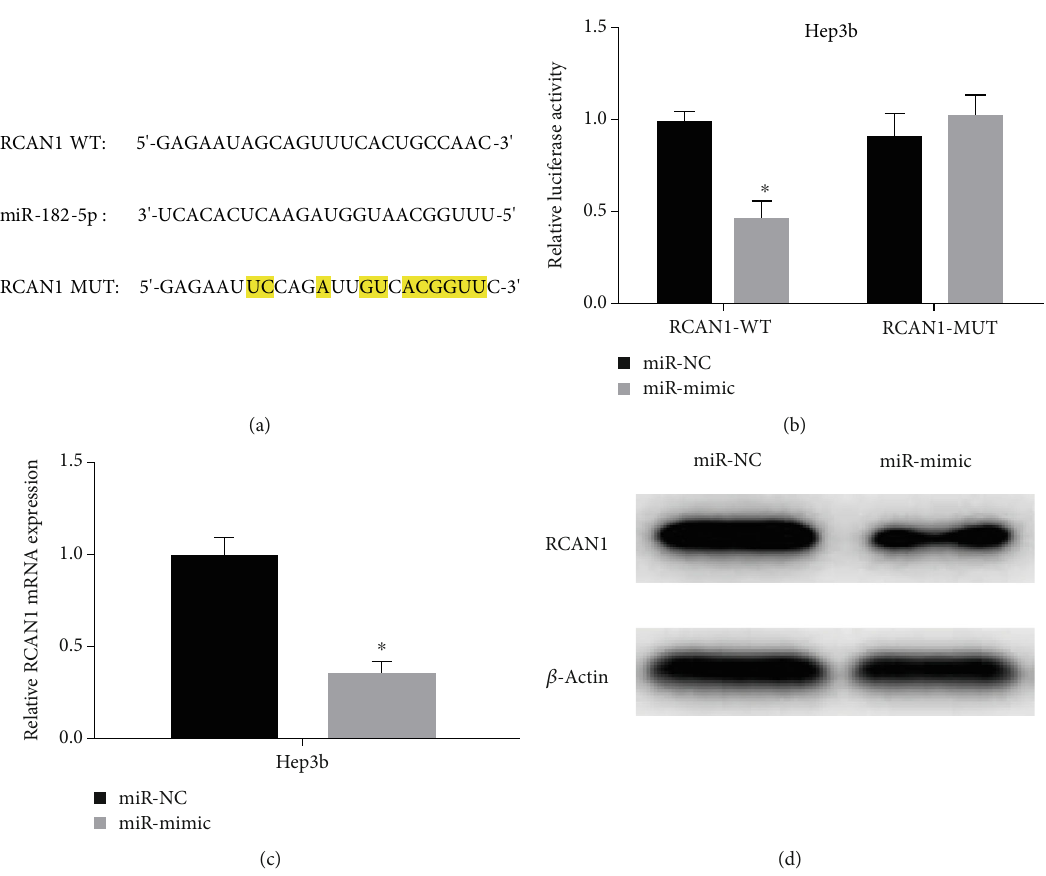
Figure 4: miR-182-5p targets RCAN1 in liver cancer cells. (a) The targeted binding sites of miR-182-5p and RCAN1 were predicted via bioinformatics; (b) The luciferase activities of the Hep3b cell line in di ff erent transfection groups were measured by dual-luciferase reporter gene assay; (c) the expression of RCAN1 mRNA in di ff erent transfection groups of the Hep3b cell line was assessed through qRT-PCR; (d) the protein expression of RCAN1 in Hep3b cell line in various transfection groups was detected by western blot; ∗ p < 0 : 05